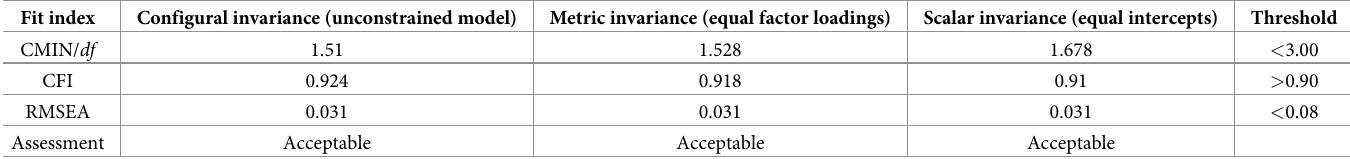
Table 5. Measurement